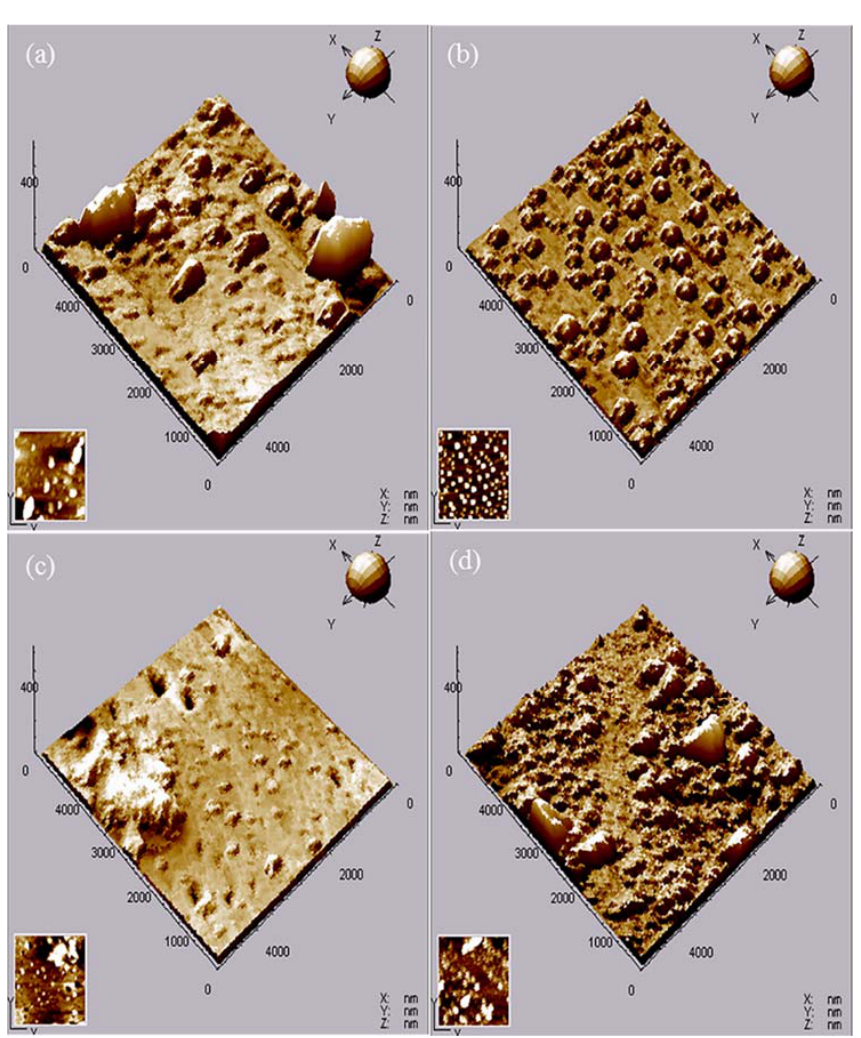
Figure 5. AFM images of different nano ‐ ZrO 2 ‐ modified coatings after 192 h acid immersion: Z ‐ 0 coating ( a ), Z ‐ 1 coating ( b ), Z ‐ 3 coating ( c ), and Z ‐ 5 coating ( d ). Table 3. Atomic compositions (at %) derived from XPS survey spectra for the Z ‐ 0, Z ‐ 1, Z ‐ 3 and Z ‐ 5 coatings before and after acid immersion.